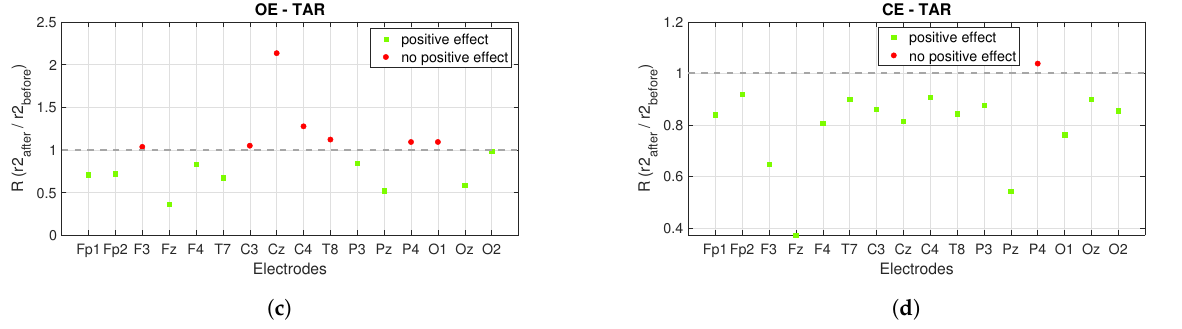
Figure 9. The short-term effect of PBM stimulation on the power spectrum is observed using TAR . The figures show the ratios of TAR for the r 1 and r 2 recordings. ( a ) shows the ratios of TAR for the r 1 after and before PBM stimulation under the condition OE , while ( b ) shows the ratios of TAR under the condition CE . ( c , d ) show the ratios for the r 2 and TAR after and before stimulation was compared.